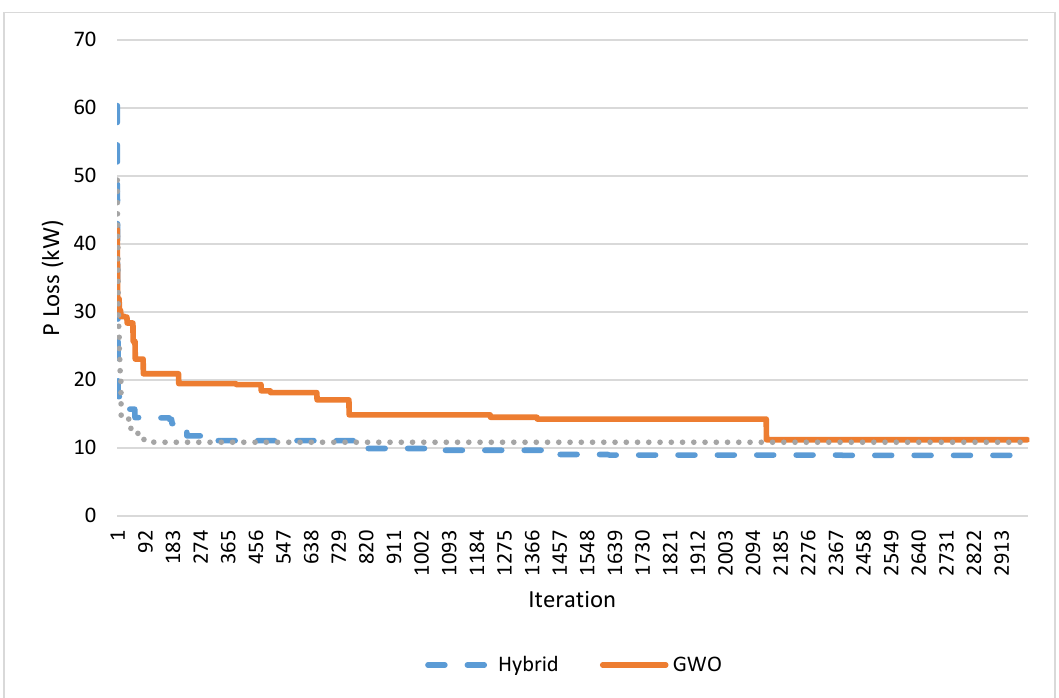
Figure 6. Voltage profile of a 33-bus system using a hybrid technique.